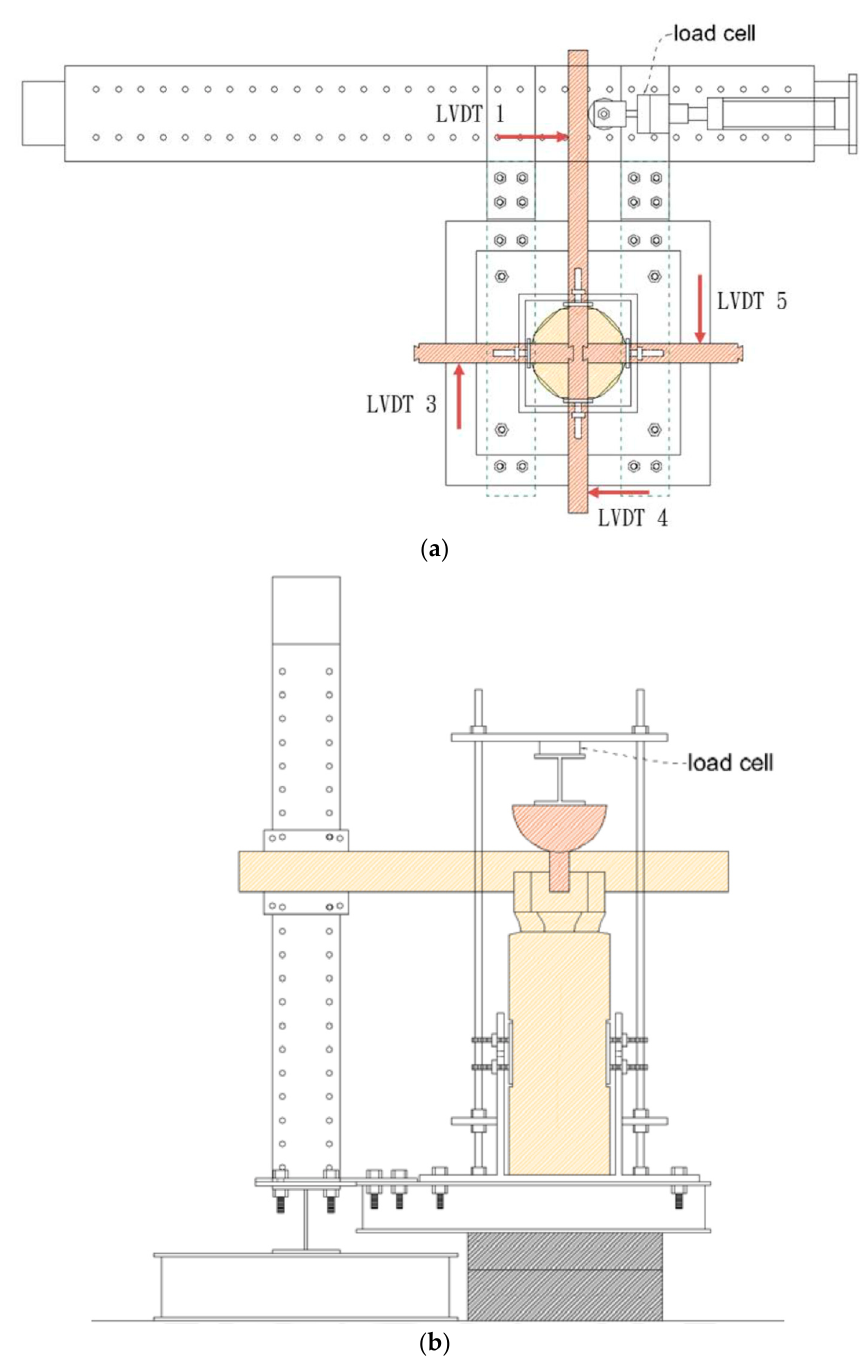
Figure 8. Testing rig of rotational test: ( a ) plane and ( b ) side elevation.